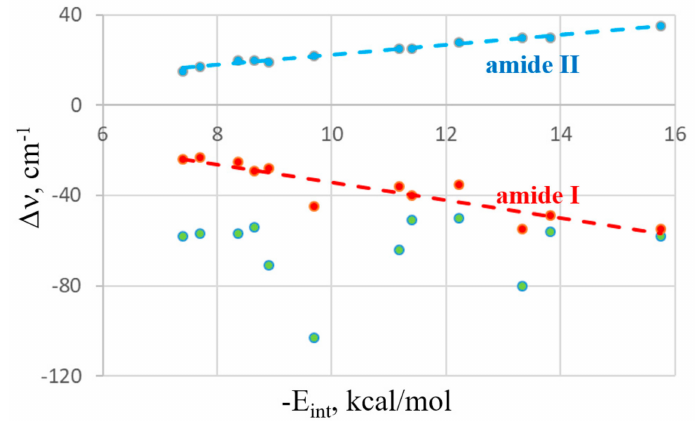
Figure 3. Relationship between MP2 / aug-cc-pVDZ interaction energy and changes in frequencies of F–X stretch (green points), amide I (red), and amide II (blue). Broken lines indicate linear fits.